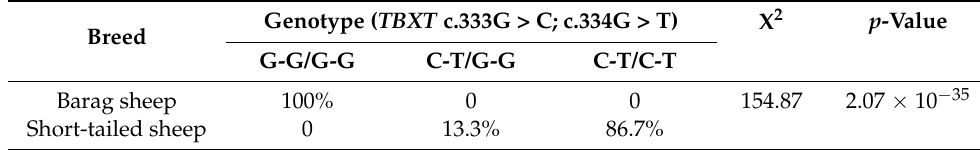
Table 2. Genotyping statistics for Barag sheep and short-tailed